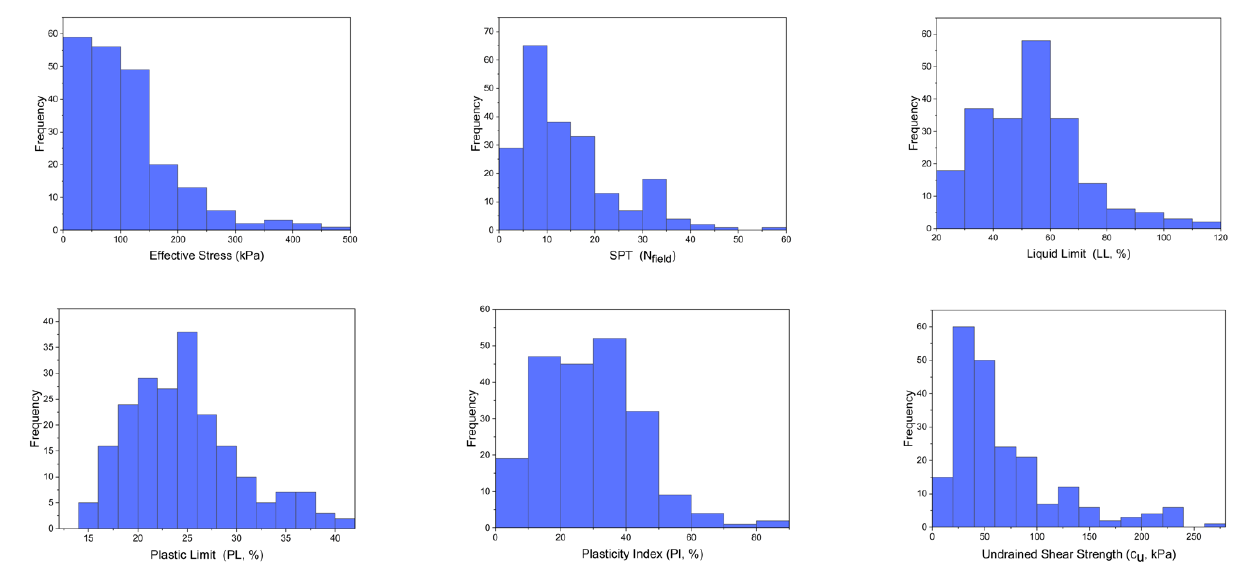
Figure 1. Histogram of the variables used for the model development. Table 3. Descriptive statistics of parameters.